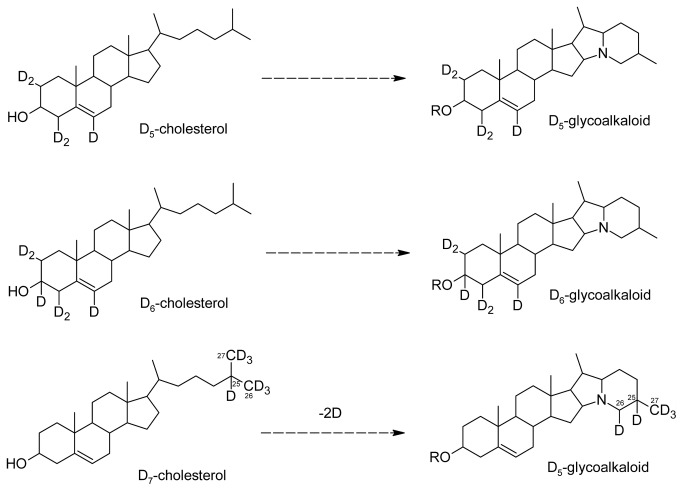
A model for the conversion of different deuterium (D) -labelled cholesterol substrates to D-labelled glycoalkaloids.Cut potato shoots were fed D5- or D6-cholesterol (labelled in the sterol ring structure), or D7-cholesterol (labelled in the sterol side chain). All these labels were converted in
vivo to D-labelled SGA. Labels in the ring structure were intact after conversion to SGA, but two D atoms were lost from the side-chain label, indicative of an aldehyde formation, likely at the C-26 position. R signifies either OH (solanidine), chacotriose (α-chaconine), or solatriose (α-solanine).